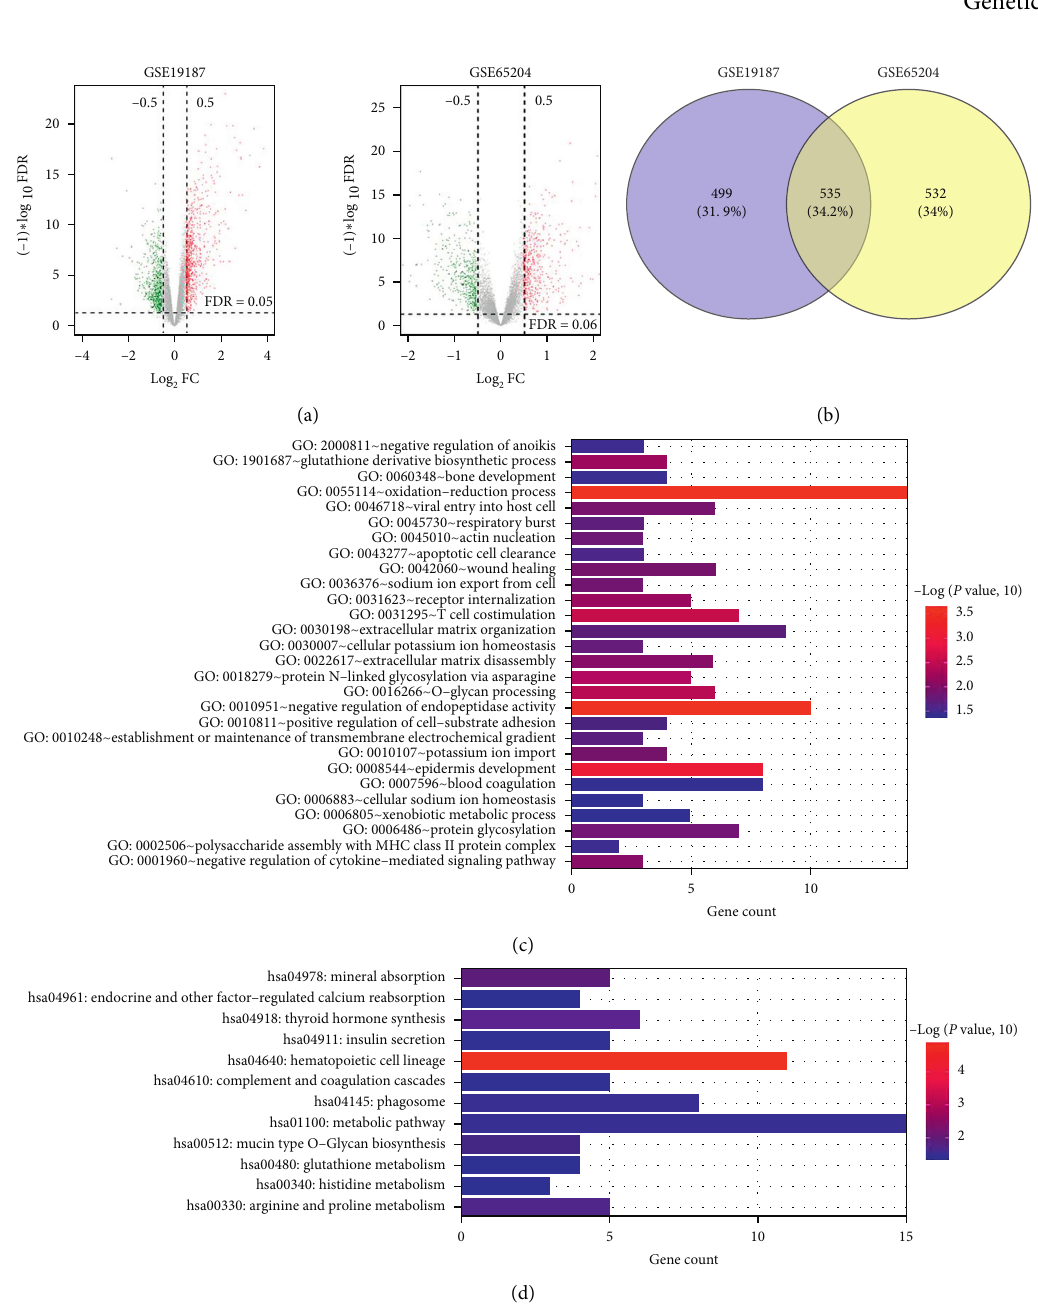
Figure 1: Identification of differentially expressed RNAs (DERs) and functional analyses of overlapped differentially expressed mRNAs (DE-mRNAs). (a) The volcano figures of DERs. Left: the volcano figure of DERs in the GSE19187 dataset. Right: the volcano figure of DERs in the GSE65204 dataset. Green and red dots represent downregulated and upregulated DERs, respectively. The horizontal dotted line represents the value of the false discovery rate < 0.05; the vertical dotted line represents the value of the |log 2 fold change (FC)| > 0.5. (b) Venn diagram of DERs found in the GSE19187 and GSE65204 datasets and DERs common between them. (c) Biological processes (BPs) significantly associated with overlapped DE-mRNAs. (d) The overlapped DE-mRNAs significantly enriched in Kyoto Encyclopedia of Genes and Genomes (KEGG)